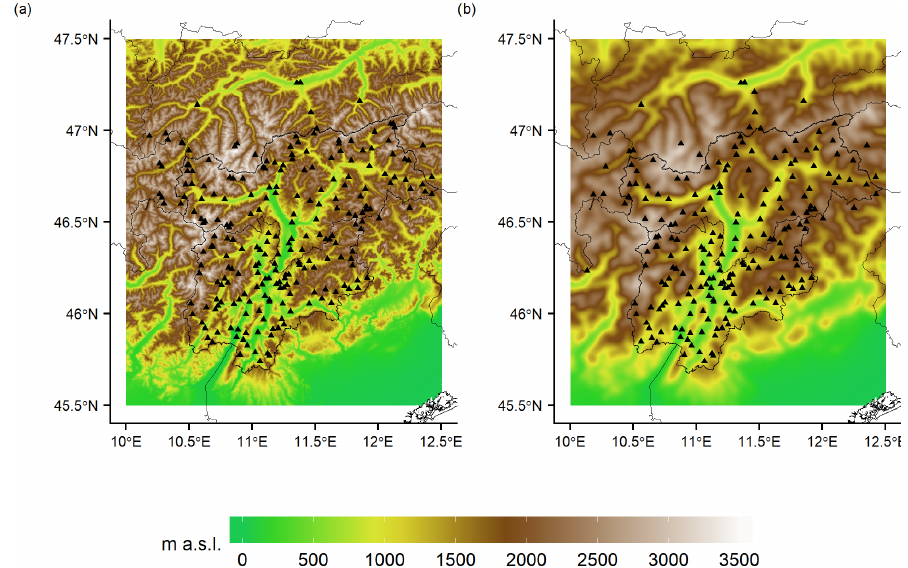
Figure 2. Spatial distribution of (a) temperature and (b) precipitation weather stations superimposed onto the topography considered in the interpolation scheme. In panel (a) the digital elevation model (DEM) at 250m resolution is reported, and in panel (b) the smoothed version of the 250m DEM used for precipitation spatialization is shown.